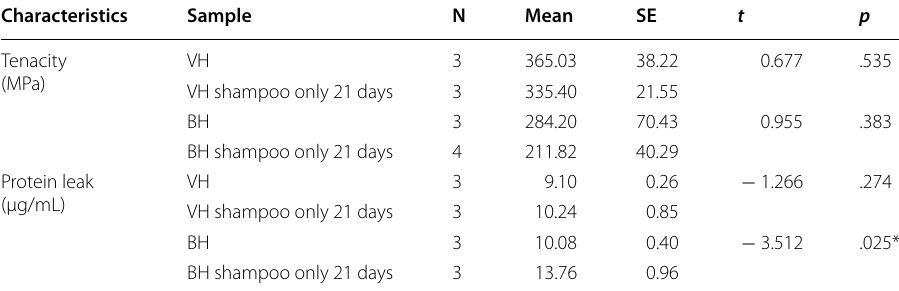
Table 19 Effect of shampooing on virgin hair and bleached hair Characteristics